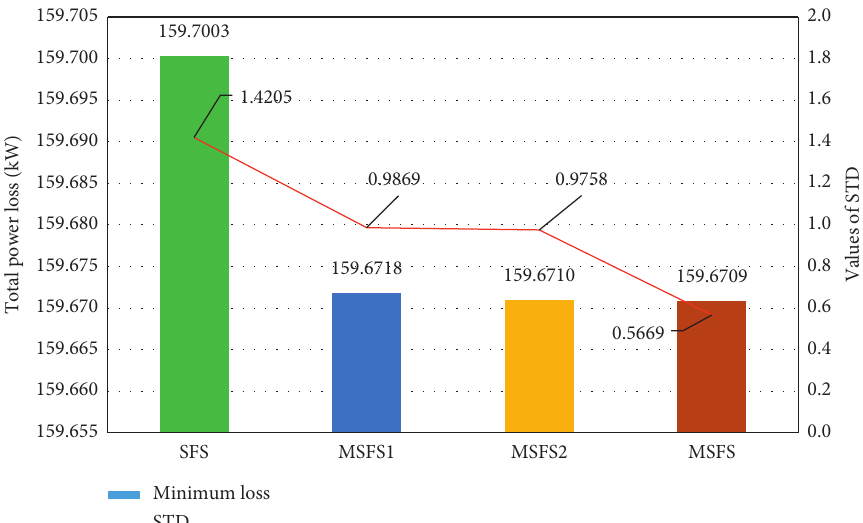
Figure 19: Minimum power loss and standard deviation of 50 trial runs obtained by SFS methods for case 1 of the 85-bus system.